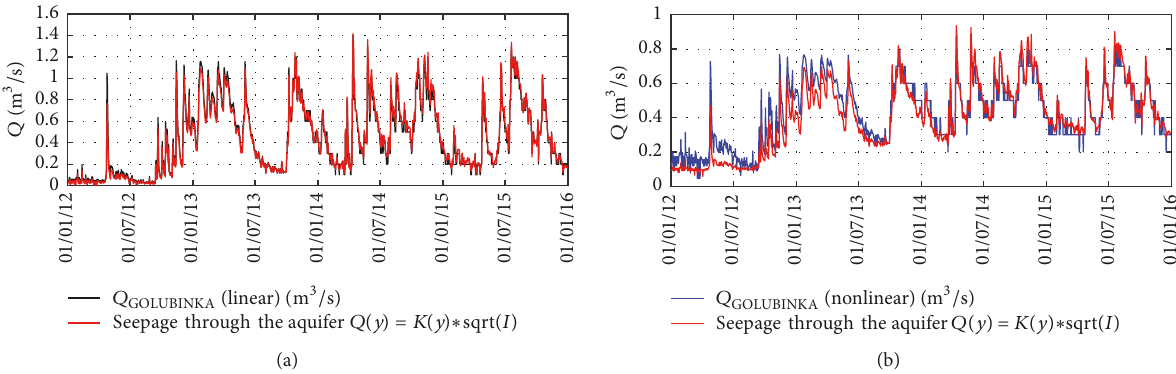
Figure 5: Time series of the amount of seepage through the Golubinka catchment (groundwater flow in the aquifer) and discharge at the Golubinka spring.